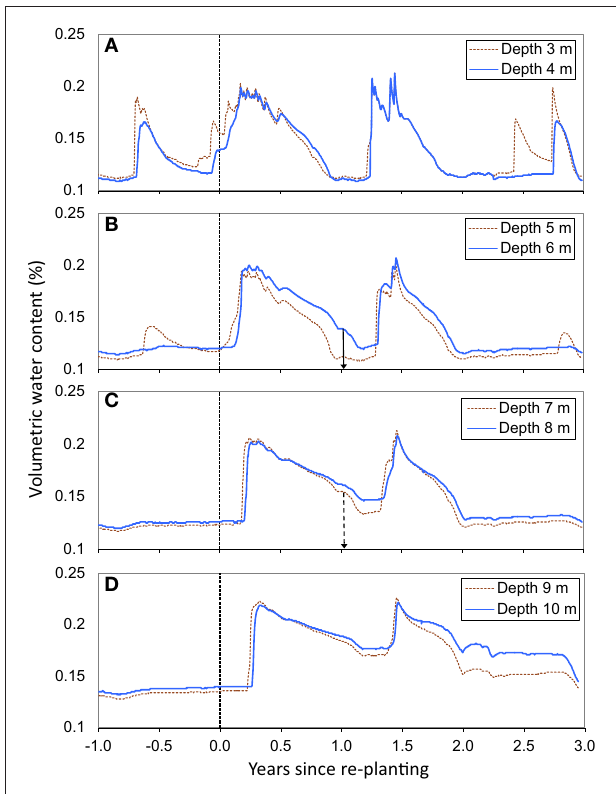
FIGURE 3 | Time series of daily rainfall (A) and mean stand height (filled circles) as well as root front depth (empty circles) estimated from soil water content monitoring and soil coring at 2.1 years (empty triangles) after replanting the oldest stand of the chronosequence (B). Standard deviations of tree height ( n = 336) and root front depth at age 2.1 years ( n = 3) are shown. The dotted line shows the symmetrical belowground of mean tree